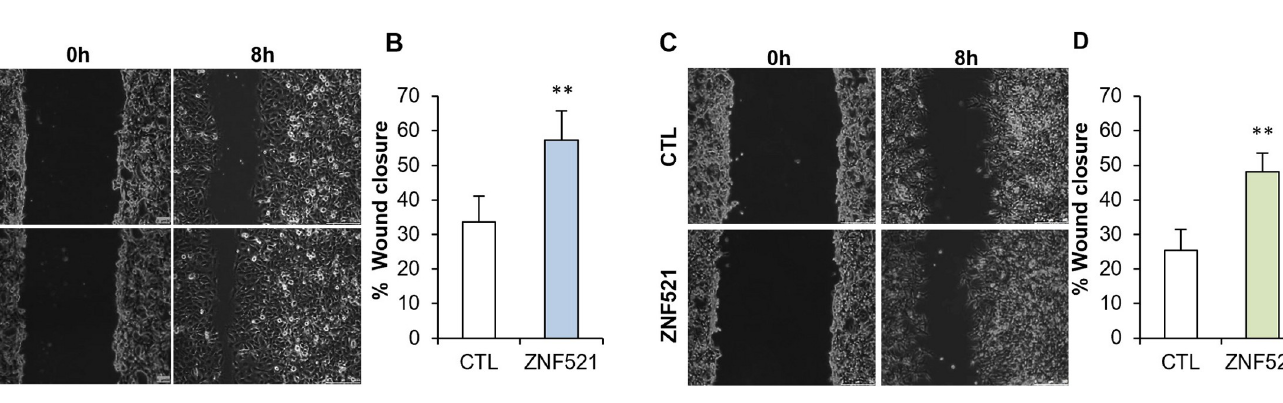
Fig 3. Effect of enhanced ZNF521 expression on migration ability of HeyA8 and ES-2 cell lines. ZNF521-transduced HeyA8 (A and B) and ES-2 (C and D) displayed an increased wound healing ability compared to control cells. Scale bars correspond to 250 μ m. As percentage of wound closure the mean of 3 sets, each conducted in triplicate, is illustrated (B and D). Asterisks indicate p < 0,05 � , p < 0,01 �� , p < 0,001 ���